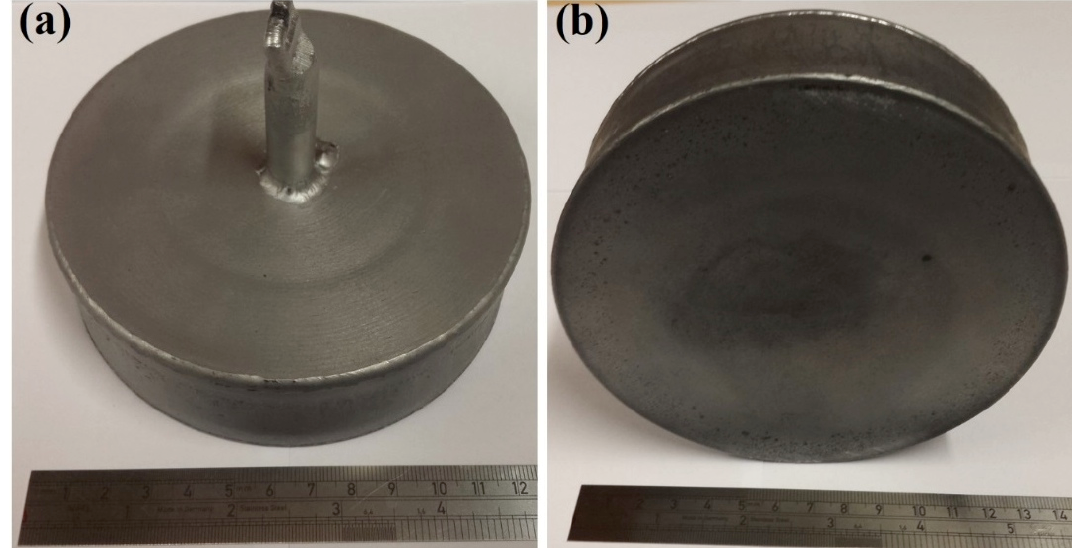
Figure 9. Images of the powder canister after HIPping: ( a ) top view of the component, showing a shallow sink mark in the middle part of the component where the disk is located; ( b ) the bottom side of the canister showing even shrinkages towards to the centre and also a shallow sink mark on the bottom of the canister.